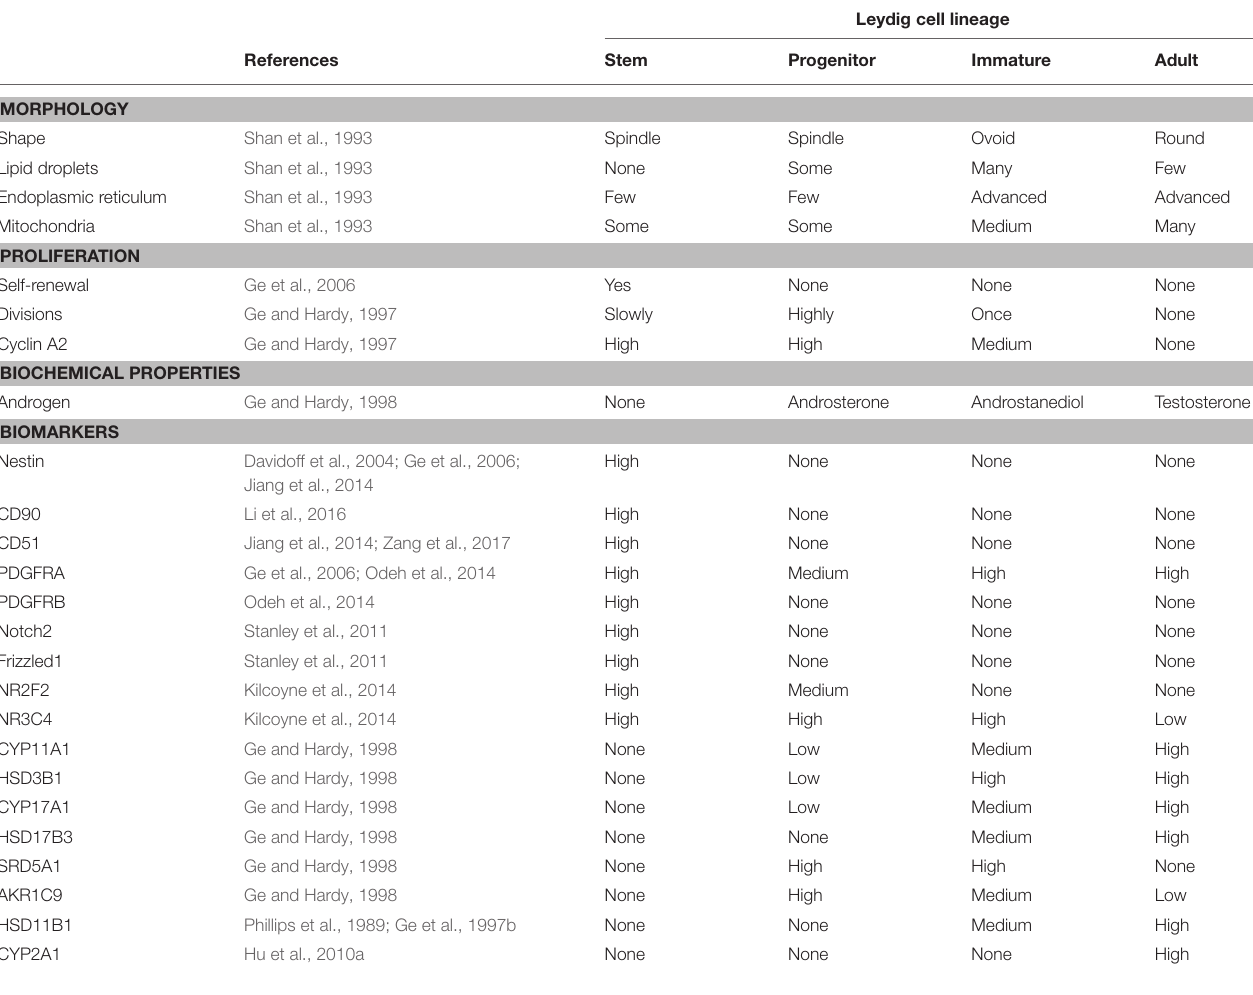
TABLE 1 | The summary of cell properties in the adult Leydig cell